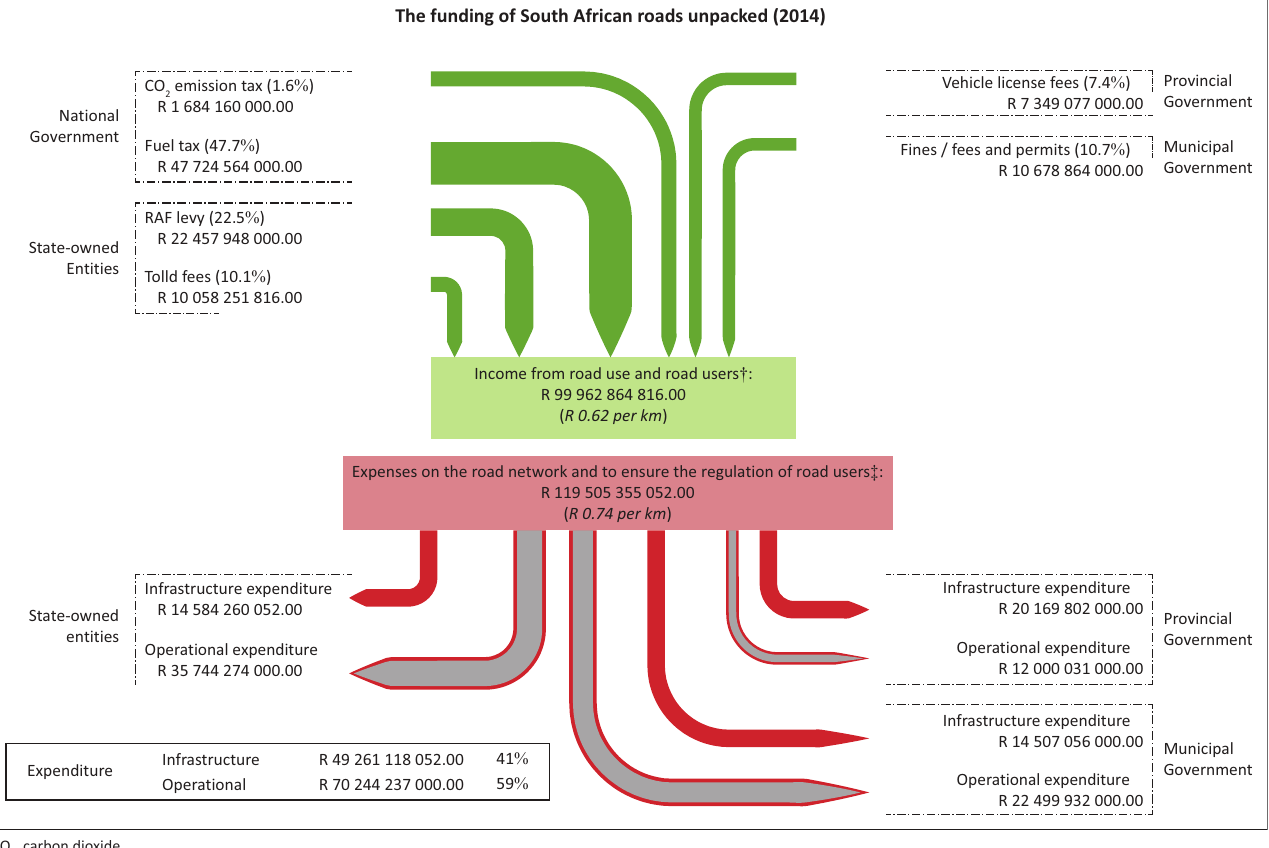
FIGURE 1: The funding of roads in South Africa